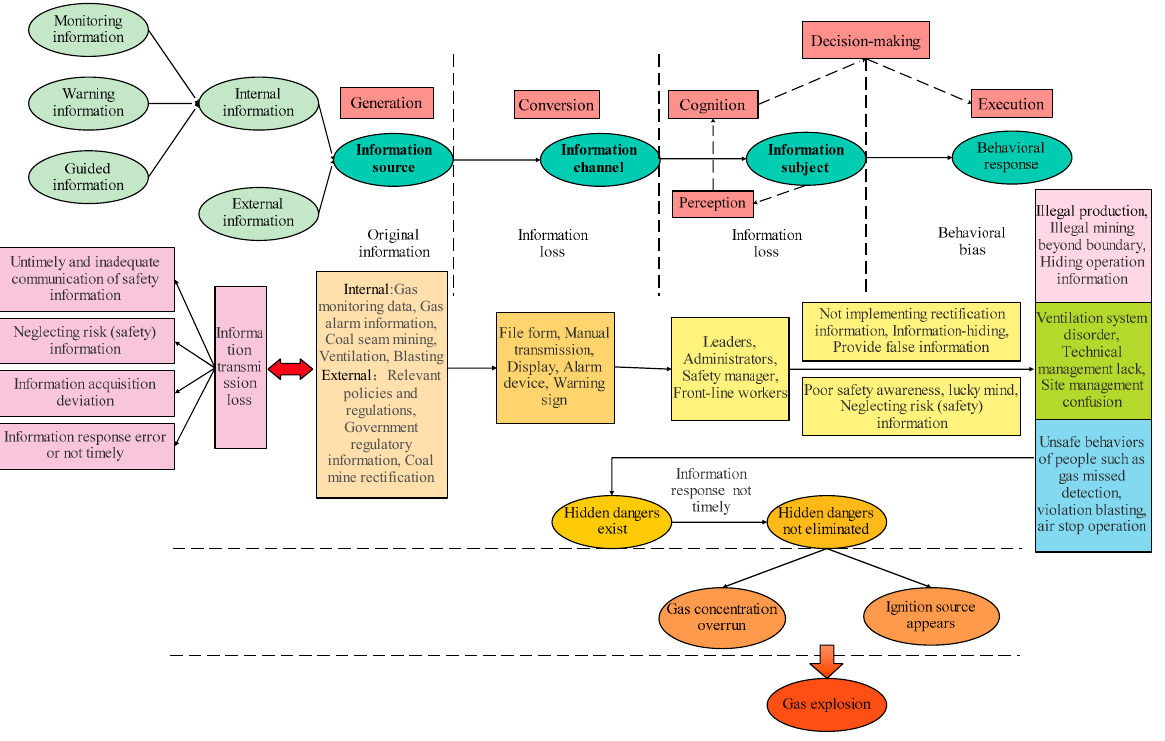
Figure 2. Accident-causation model of coal mine gas explosion based on safety information transmission.